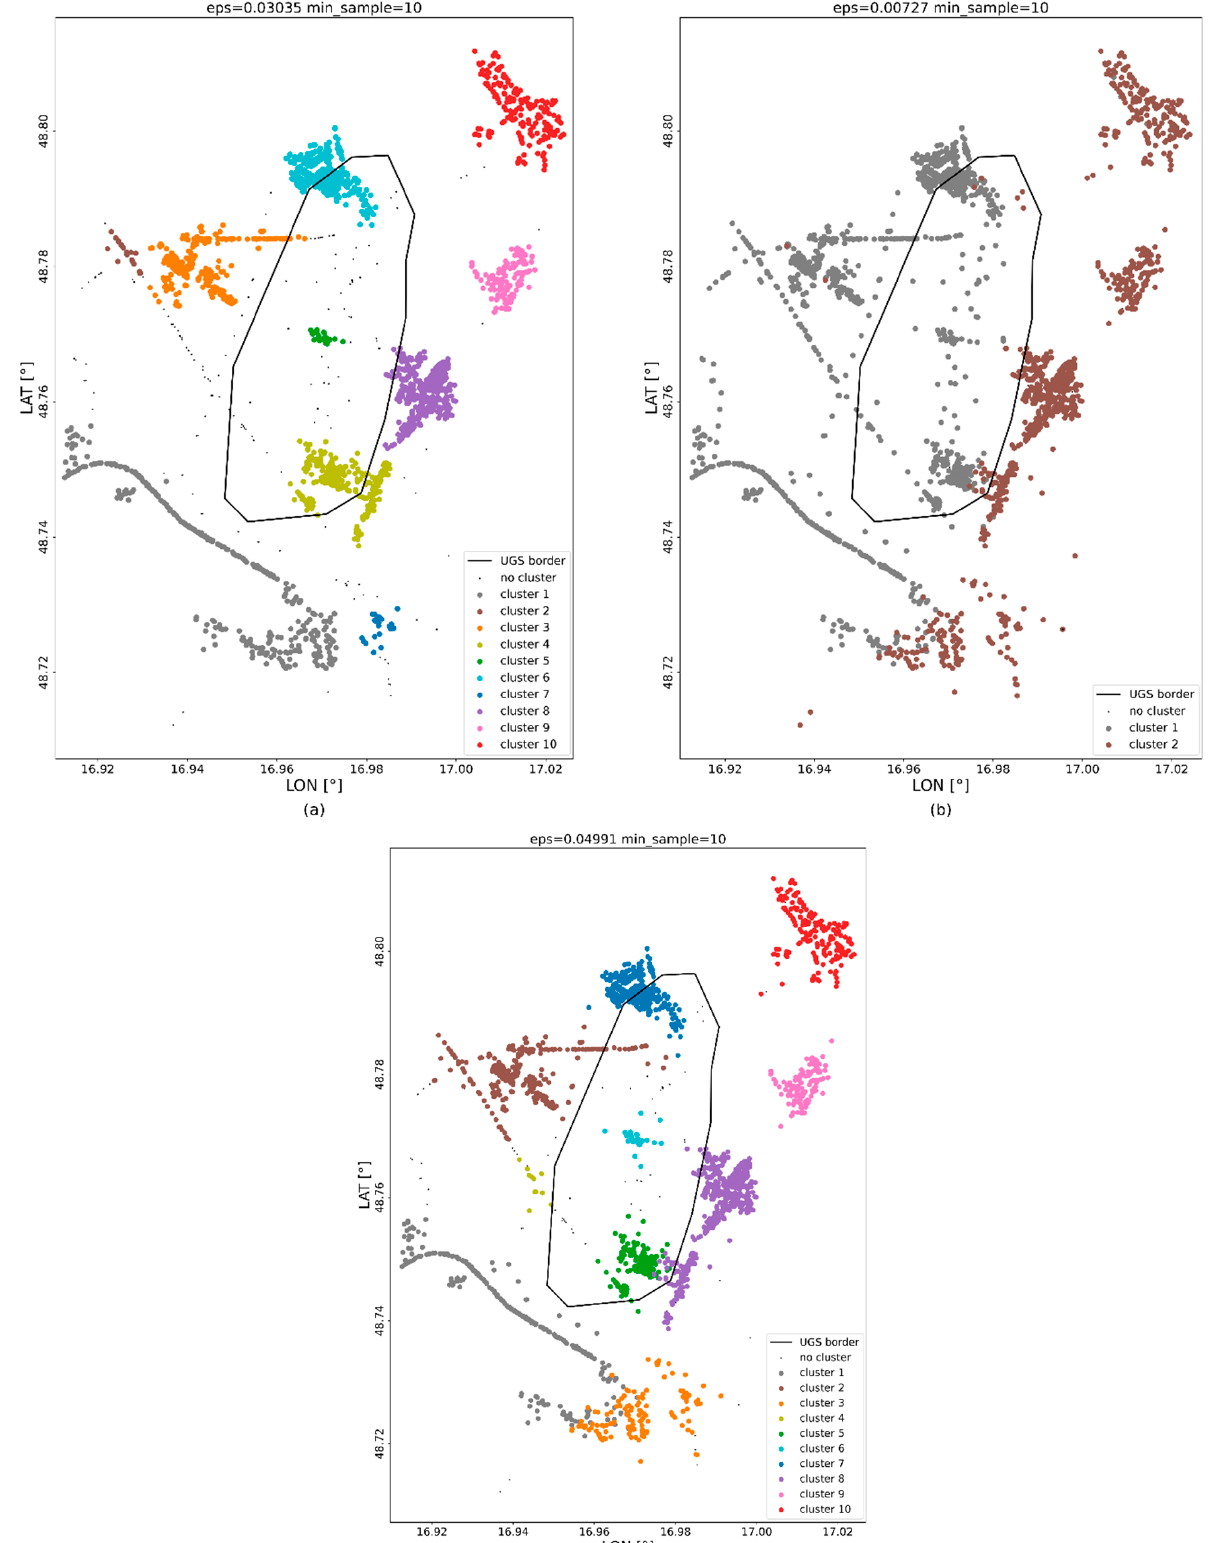
Figure 7. Clusters formed by clustering in spatial domain ( a ), attribute domain ( b ), and in their combination ( c ).